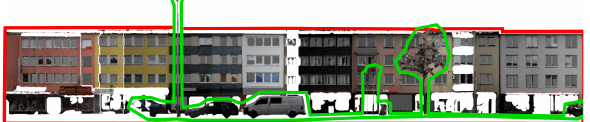
Figure 2: Resulting parallax scrolling visualization with color- labeled depth